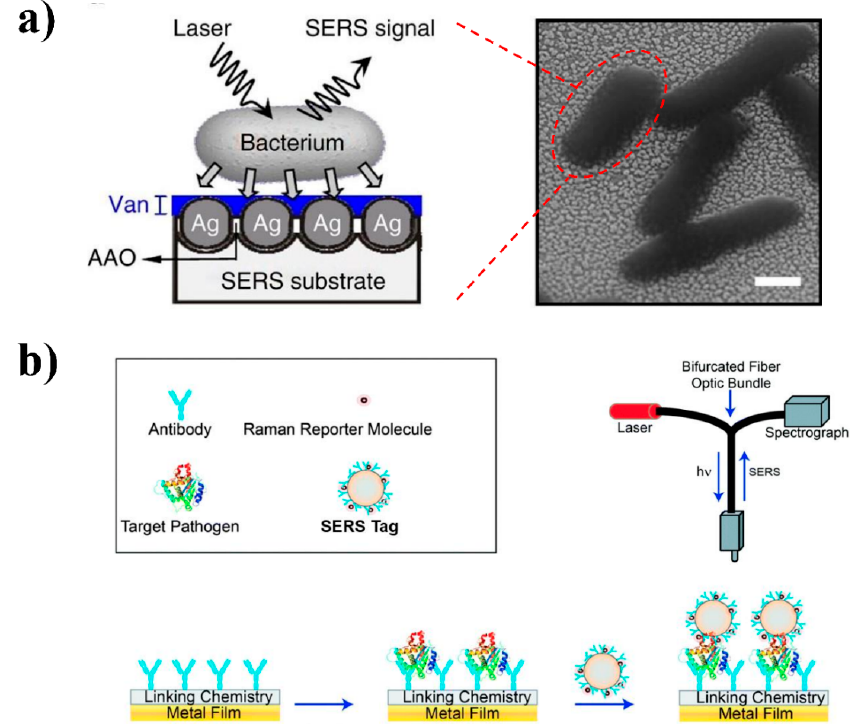
Figure 2. Representative “direct” ( a ) and “indirect” ( b ) SERS detection of bacteria. ( a ) Schematic diagram showing the SERS signal was directly collected from the bacterium on a vancomycin-coated Ag/AAO SERS-active substrate (left). Scanning electron microscope (SEM) image of bacteria on the substrate (scale bar, 500 nm) (right). ( b ) Schematic illustration of a sandwich-like indirect antibody-SERS detection. Key steps including: immobilization of antibody on the surface of metal substrate; capture of target bacteria by modified surface and labeling the target bacteria with SERS tag for detection. Reproduced with permission [83]. Copyright Springer Nature, 2011. Reproduced with permission [72]. Copyright Royal Society of Chemistry, 2011.